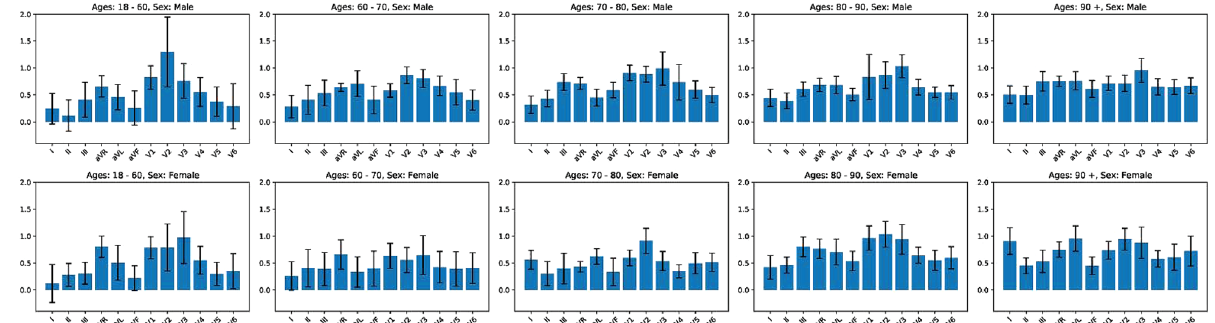
Figure 1. Lead importance in the prediction of future AF. The average contribution of each lead-specific processed signal for the prediction of future AF is shown for the ten different age-sex-specific groups of patients. 95% CIs are also reported for the average values computed.